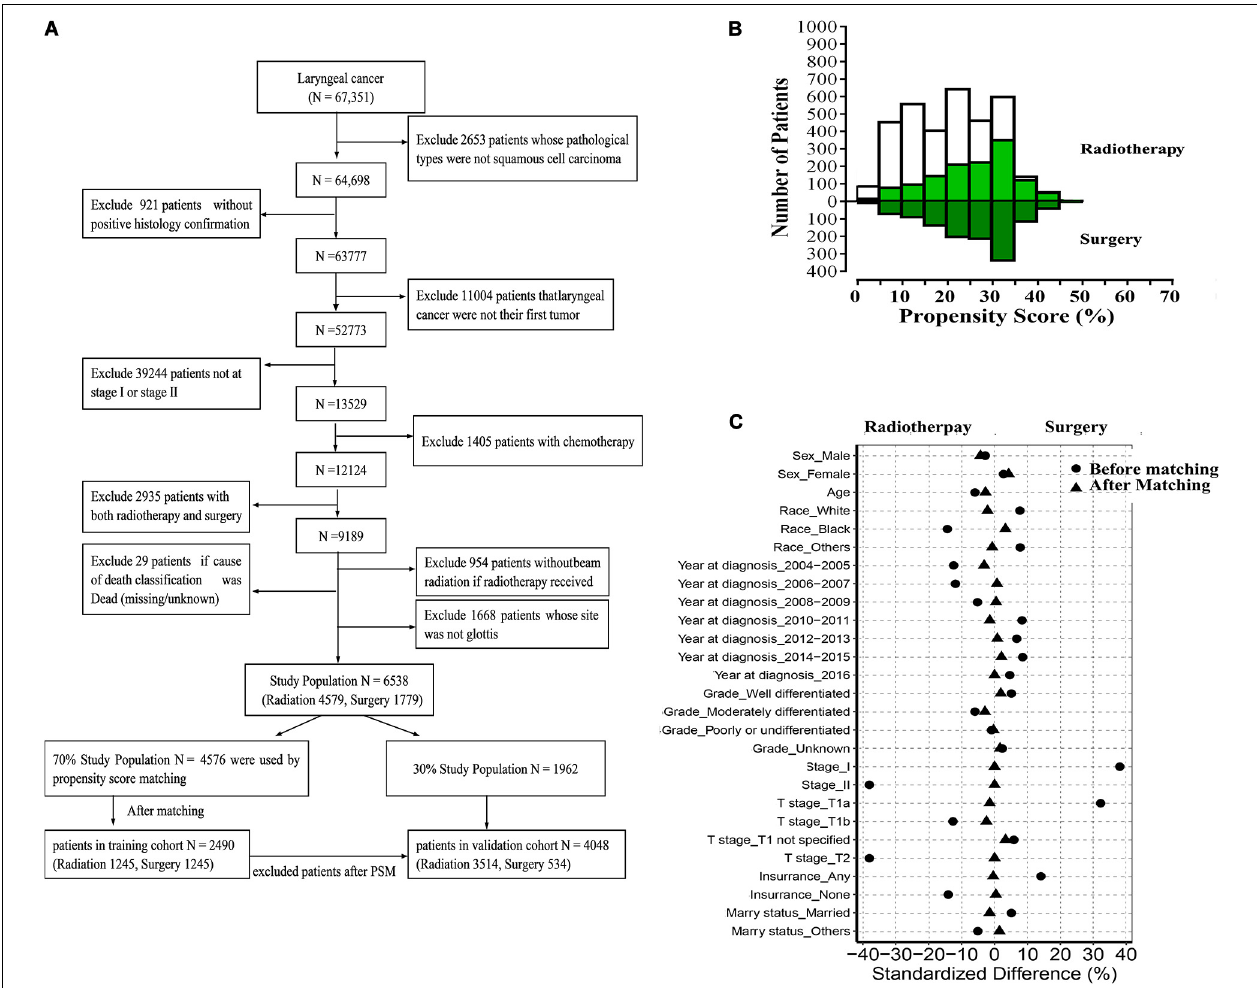
FIGURE 1 | (A) Flow diagram of selecting process (B) Mirror histogram of propensity scores for patients with radiotherapy and with surgery. Matched patients are presented in green color. (C) Standardized differences of baseline variables between patients with radiation and with surgery before and after propensity score